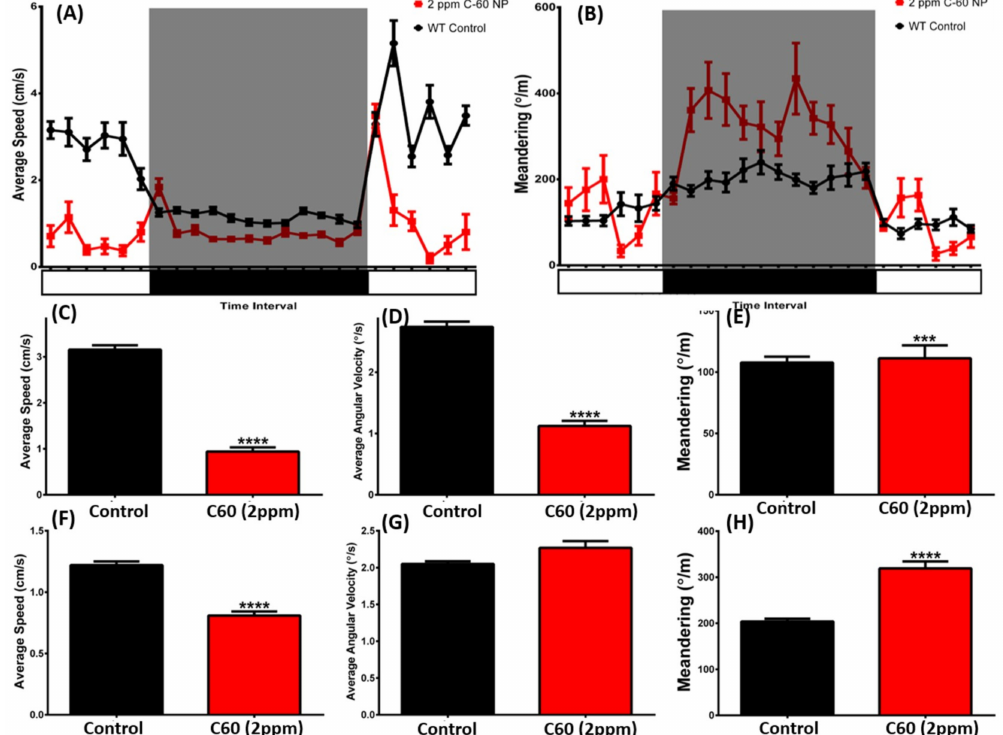
Figure 9. The circadian rhythm assay for wild-type and C 60 NPs-exposed zebrafish after 12-day exposure. Comparison of the time chronological changes of the average speed ( A ) and meandering ( B ) between wild-type and C 60 NPs-exposed fish in day and night cycle. The grey area shows the dark period and the unshaded area is the light period. Comparison of the average speed ( C ), average angular velocity ( D ), and meandering ( E ) at day cycle. Comparison of the average speed ( F ), average angular velocity ( G ), and meandering ( H ) at night cycle. The data are expressed as the mean ± SEM and were analyzed by Mann–Whitney test ( n = 28 for control; n = 18 for C 60 NPs-exposed fish; *** p < 0.005, ****, p <